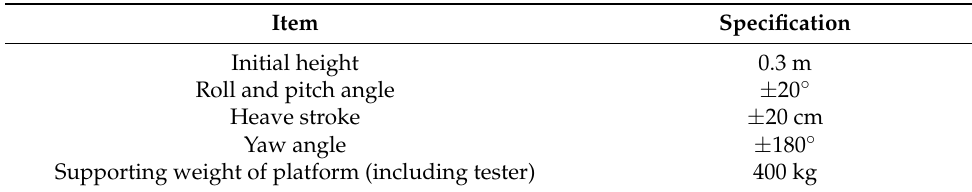
Figure 1. Definition of the platform motion. Table 1. The overall